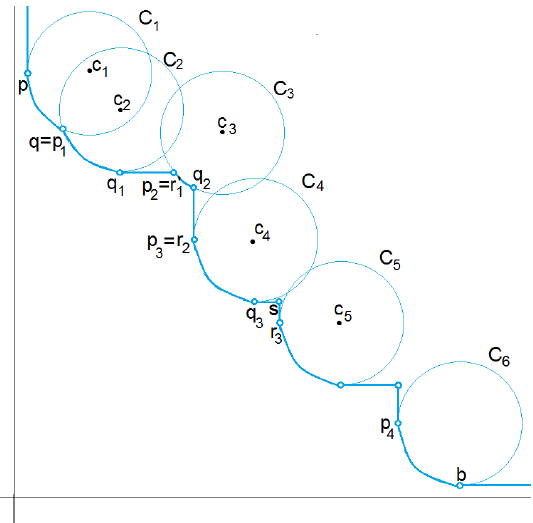
Figure 22. Each pair of adjacent circles gives a different